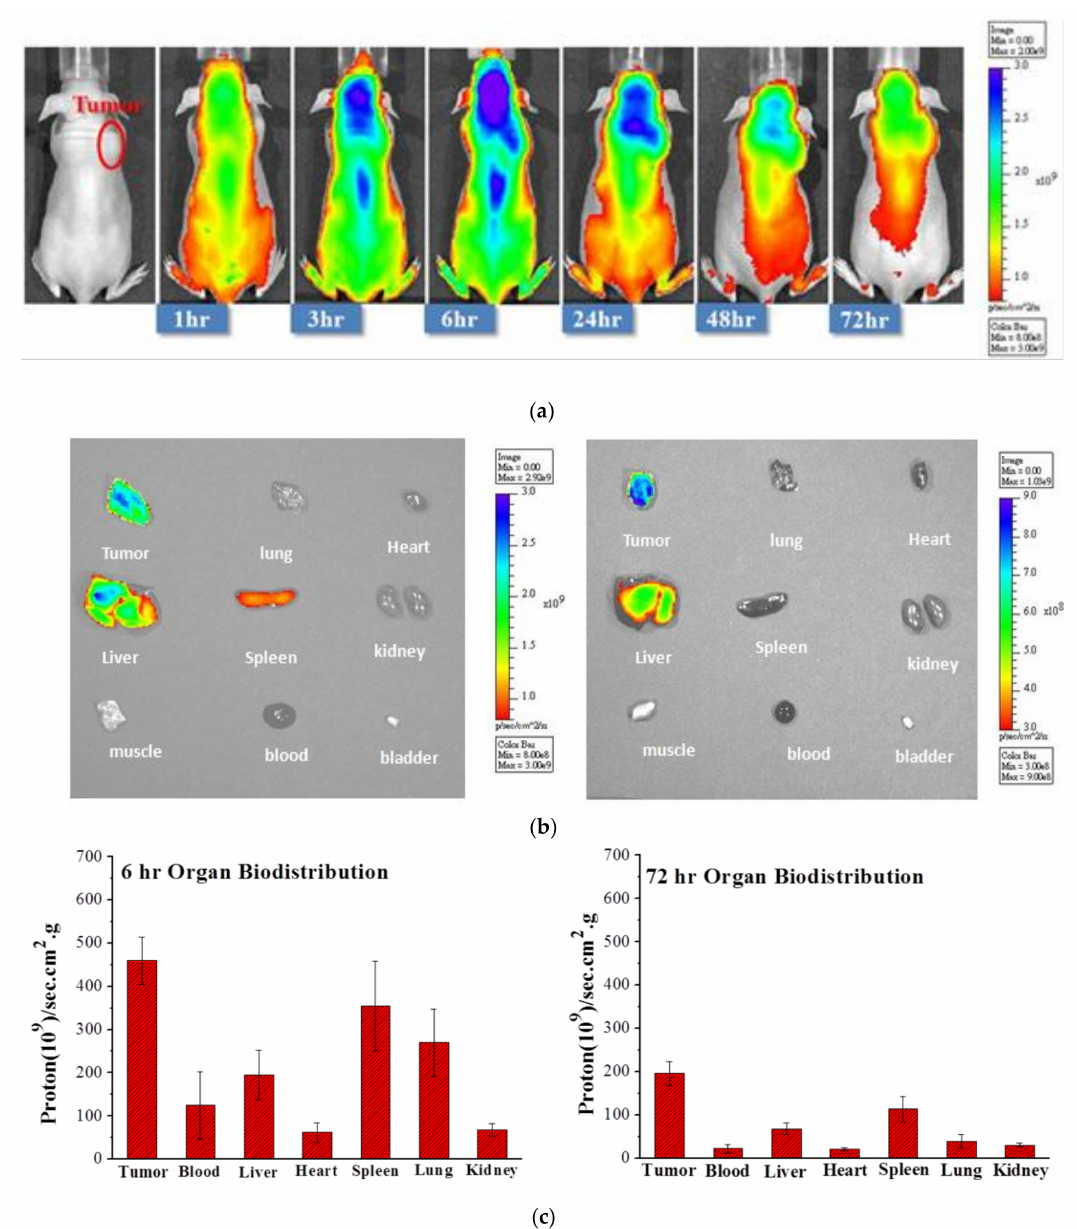
Figure 4. Tumor accumulation and biodistribution of the Dox-loaded mixed micelles. The LL/2 mouse Lewis lung cancer cells were subcutaneously inoculated into nude mice. As the tumor size grew to 5 mm in diameter, the mice were intravenously injected with Cy-5.5-labeled Dox-loaded mixed micelles. The fluorescence of the Cy-5.5-labeled Dox-mixed micelles was detected using IVIS. ( a ) In vivo optical fluorescence imaging of LL/2 tumor xenografted nude mice, which were treated with Cy-5.5-labeled Dox-loaded mixed micelles. ( b ) At 6 and 72 h post-injection, the tumor-bearing mice were euthanized, and the tumor tissues and organs were harvested. The photoimaging was performed and the fluorescence of the tumors and organs was detected to assess the biodistribution of the mixed micelles. ( c ) The proton intensities of the tumors and organs were also